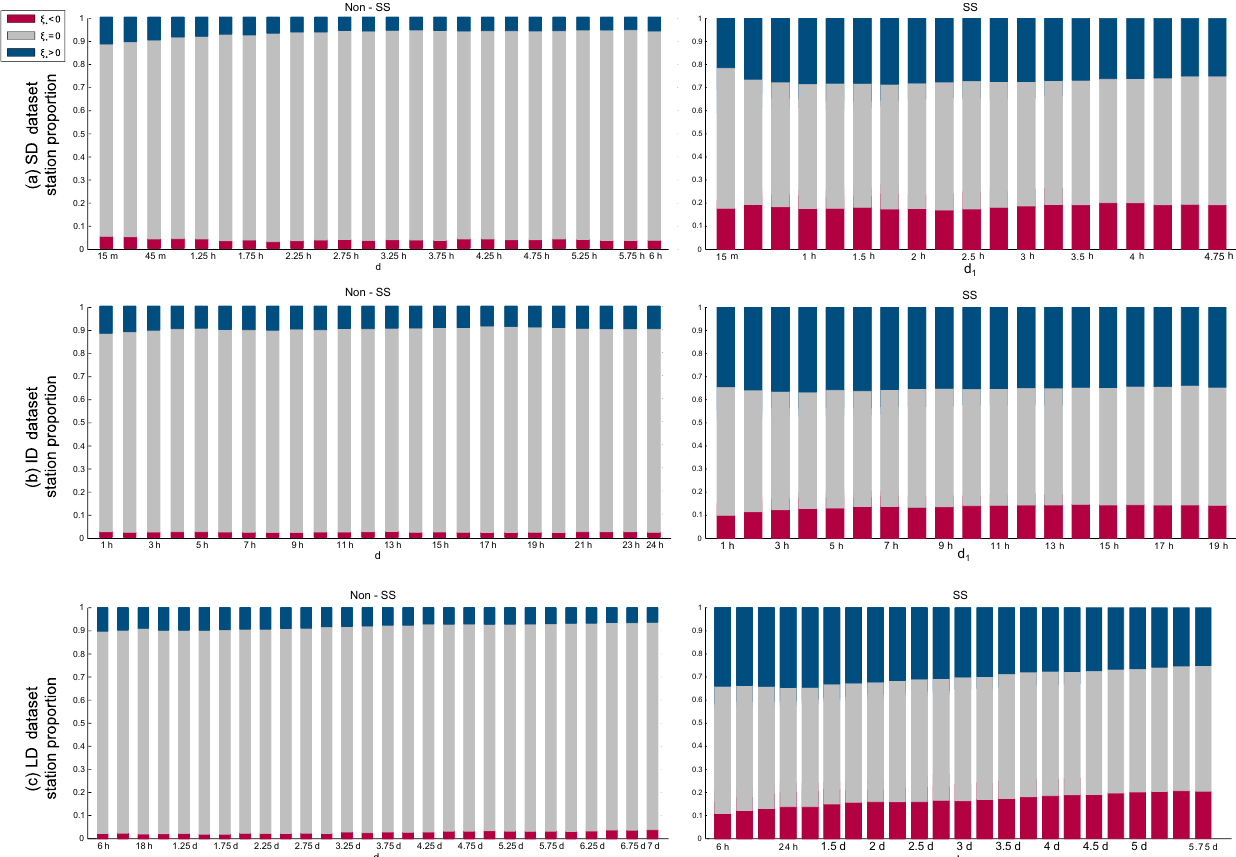
Figure 11. Stacked histograms of the fractions of valid SS stations with ξ < 0 (in red), ξ = 0 (in grey), and ξ > 0 (in blue) resulting from the Hosking test applied at the 0.95 confidence level for each duration (non-SS GEV, first column) and each 6-duration scaling interval (SS GEV, second column) for SD (a) , ID (b) , and LD (c) datasets.